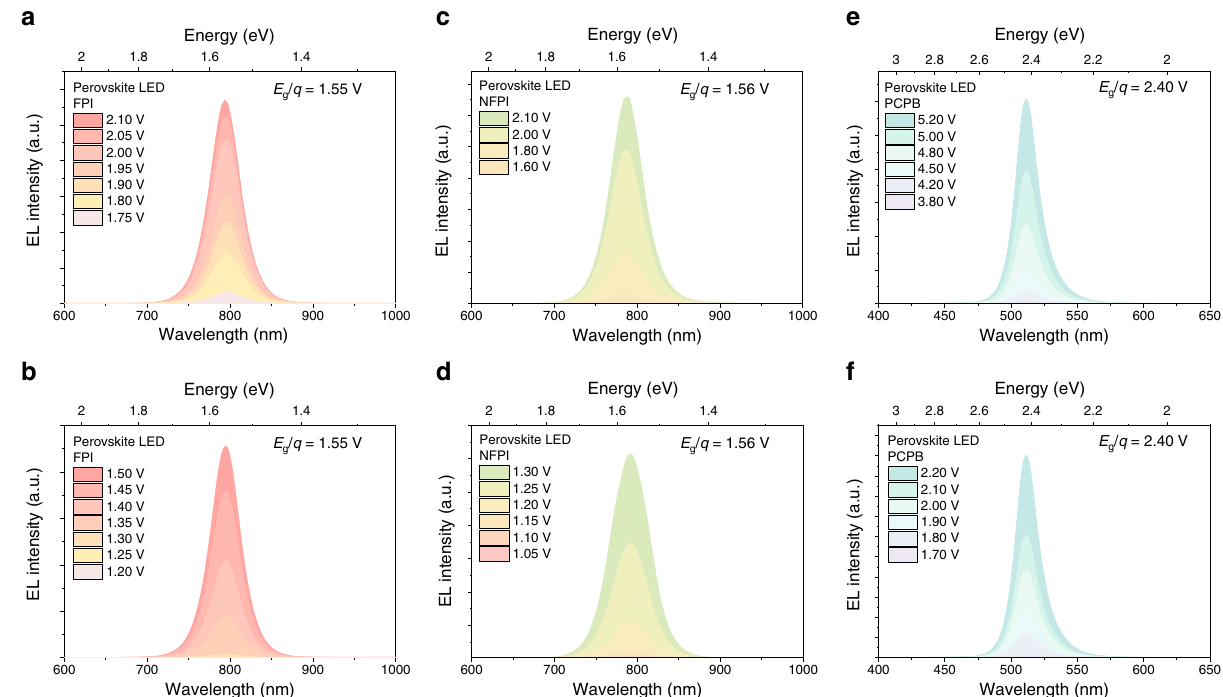
Fig. 2 EL spectra of perovskite LEDs under above- and sub-bandgap voltages. a , b EL spectra of a FPI perovskite LED driven at different bias above and below the bandgap voltage. c , d EL spectra of a NFPI perovskite LED driven at different bias above and below the bandgap voltage. e , f EL spectra of a PCPB perovskite LED driven at different bias above and below the bandgap (Fig. 3h and Supplementary Table 2). The ideality factors presented in Supplementary Table 2 fall within the range between 1 and 2.